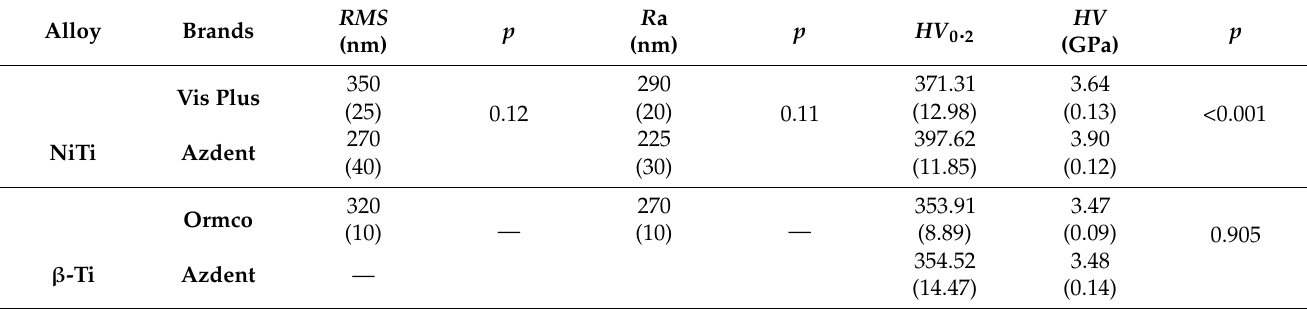
Table 2. AFM determined surface roughness parameters (Standard Deviation), Vickers